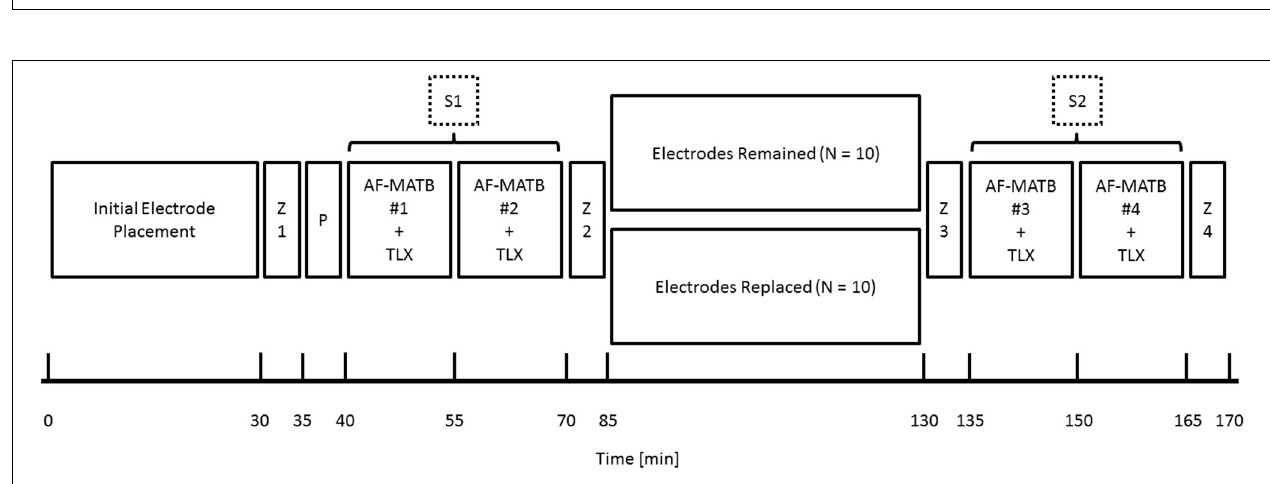
FIGURE 2 | Experimental timeline for data collection. Data collection began with initial electrode preparation and placement and an initial measurement of impedance (Z1). A 5-min practice trial (P) was given to participants to re-familiarize themselves with the task interface before beginning data collection. Session 1 (S1) consisted of two, 15-min AF-MATB trials (one at each task difficulty level and paired with a NASA-TLX assessment